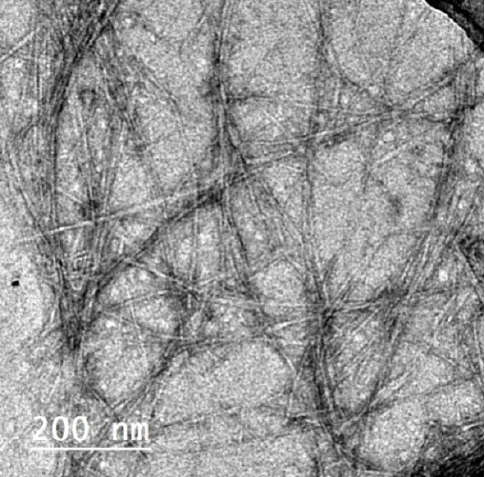
Figure 3. TEM image of cellulose nanofibers (CNFs) isolated from de-pectinated sugar beet pulp (SBP).